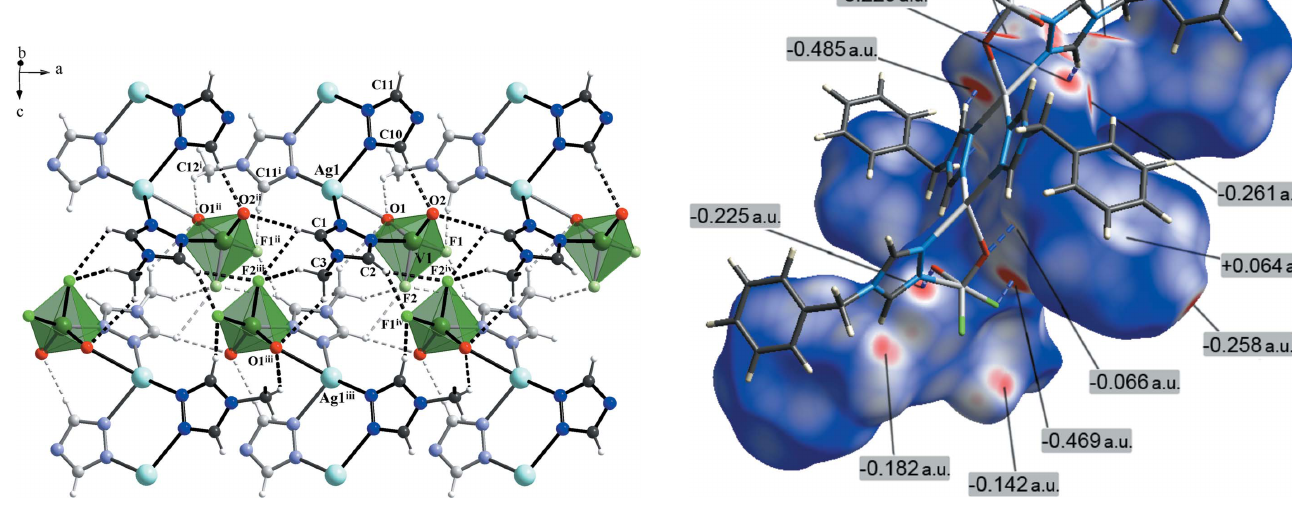
Figure 4 The Hirshfeld surface of the title compound mapped over d norm in the color range (cid:3) 0.488 (red) to 1.385 (blue) a.u., in the environment of the , closest neighbor [symmetry code: (cid:3) x + 1, (cid:3) y + 1, (cid:3) z ], with the red spots 2 indicating different kinds of intermolecular interactions.